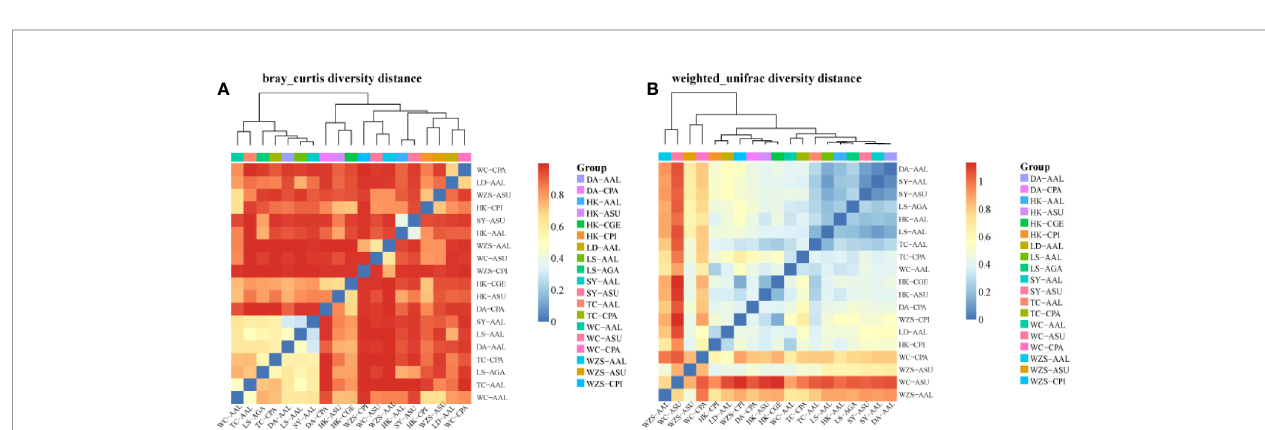
FIGURE 6 | Matrix heatmap of Bray-Curtis distances (A) and Weighted unifrac Beta diversity (B) between microbial communities of six mosquito species from eight areas.